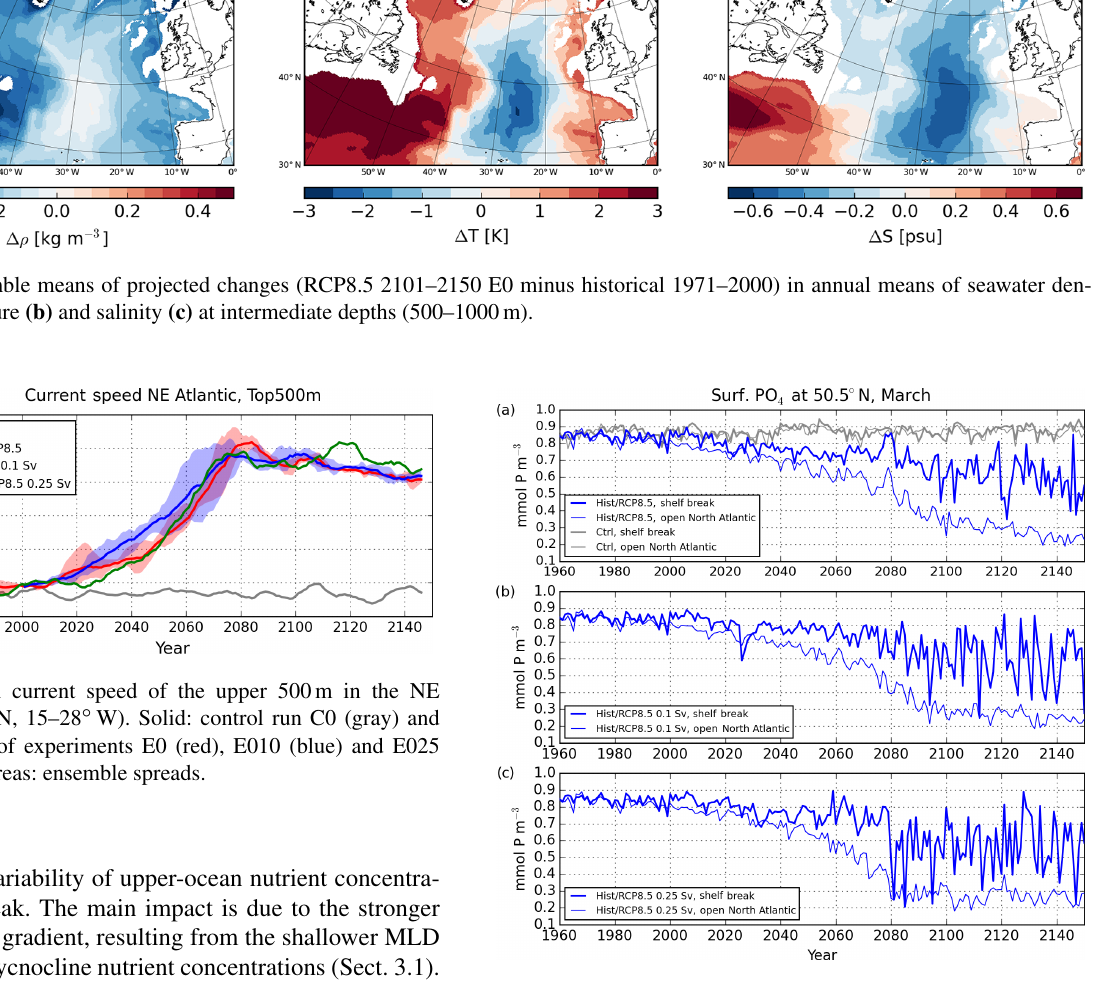
Figure 12. Pre-bloom (March) surface phosphate concentrations at 50.5 ◦ N (Fig. 4, S1) at the Celtic shelf break (10–12 ◦ W, thick lines) and in the open NE Atlantic (15–20 ◦ W, thin lines) for the control run C0 (gray) and single realizations (blue) of experiments E0 (a) , E010 (b) and E025 (c) . Two more ensemble members for E0 and E010 are shown in Fig.